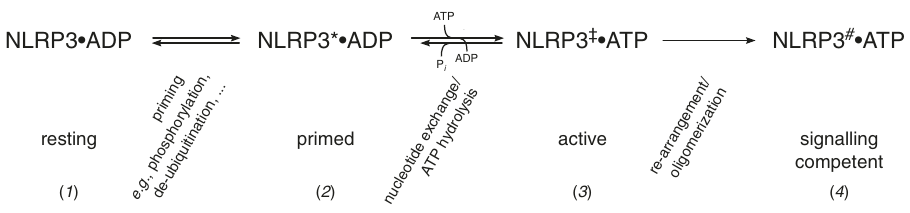
Fig. 7 Schematic representation of the proposed activation mechanism of human NLRP3. From an inactive, resting state (1) the protein is turned, for example, by reversible PTMs such as phosphorylation, into a primed state (2) characterized by loss of autoinhibition. This state is capable of ATP uptake, which converts the protein to an active state (3). The ability of intrinsic ATP hydrolysis allows the protein to relapse to its resting or primed state. The active protein is eventually able to assemble into a quaternary structure, state (4), competent for downstream signaling, such as the induction of ASC fi